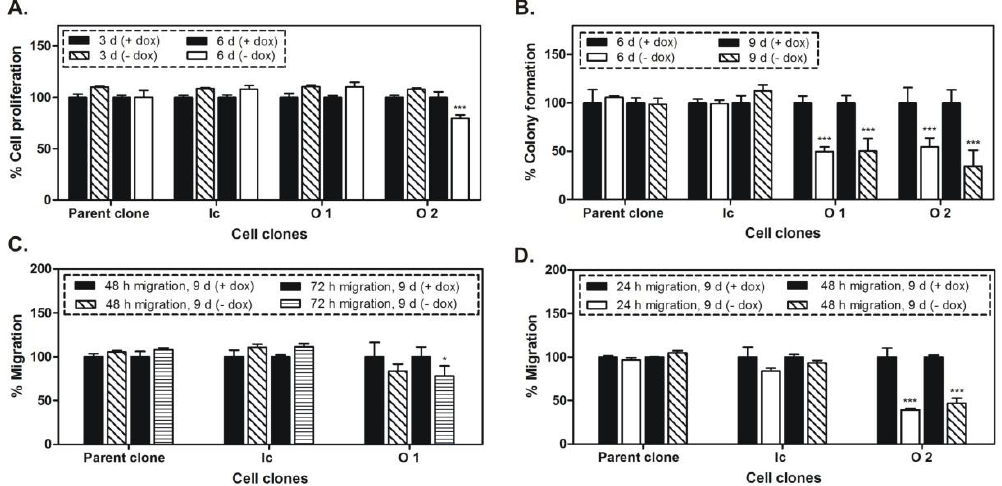
Figure 2. Cellular properties upon conditional OPN knockdown. ( A ) Cell proliferation assay (MTT assay); ( B ) Colony formation assay; ( C , D ) Migration assay. The parent cell clone and a cell clone (Ic) containing the gene cassette without the specific miRNA targeting OPN were used as an additional controls to the + dox controls of the cell clones O1 and O2. The proliferation was significantly decreased in cells of the O2 clone only, but the colony formation and migration abilities were inhibited in both cell clones, although more pronounced in O2 cells. * p < 0.05; *** p < 0.001.